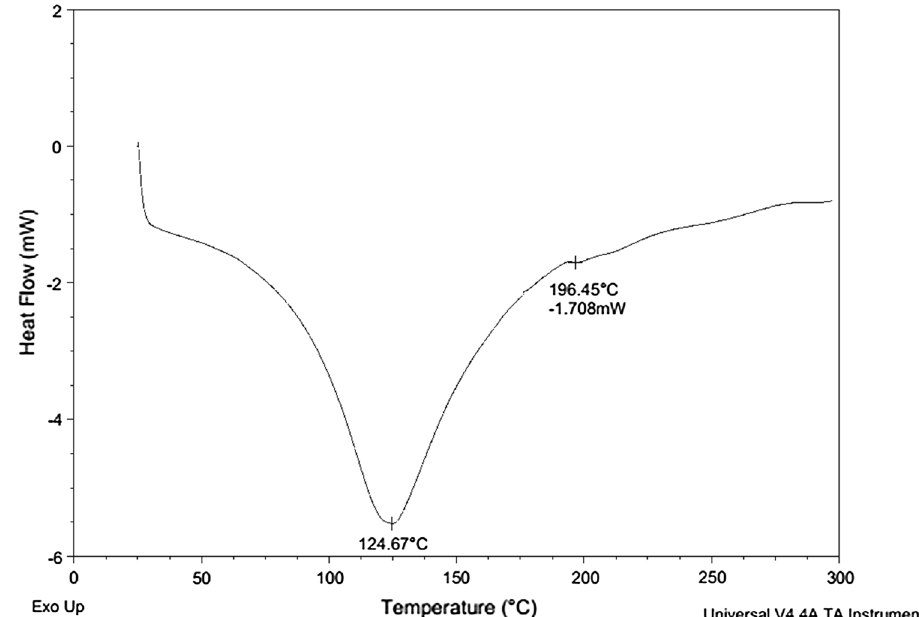
Fig. 3 DSC chart of Brachyste- gia eurycoma precursor